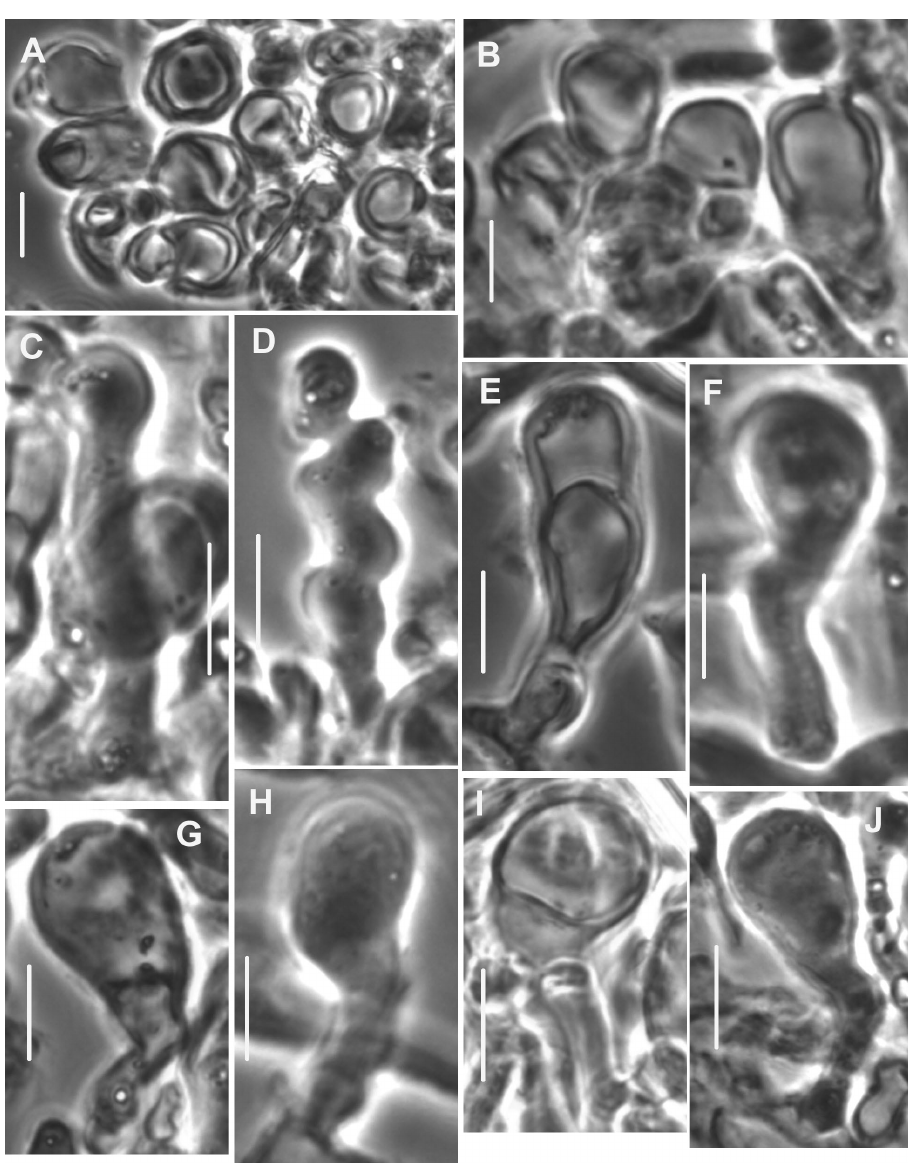
Figure 53. Mycetinis opacus . Pileipellis elements; thick-walled inflated hyphal termini. A Perpendicular view of hymeniform epicutis B Side view of a small cluster of inflated elements C–J Individual thick- walled, inflated hyphal termini. Standard bars = 10 µm. TFB 14629